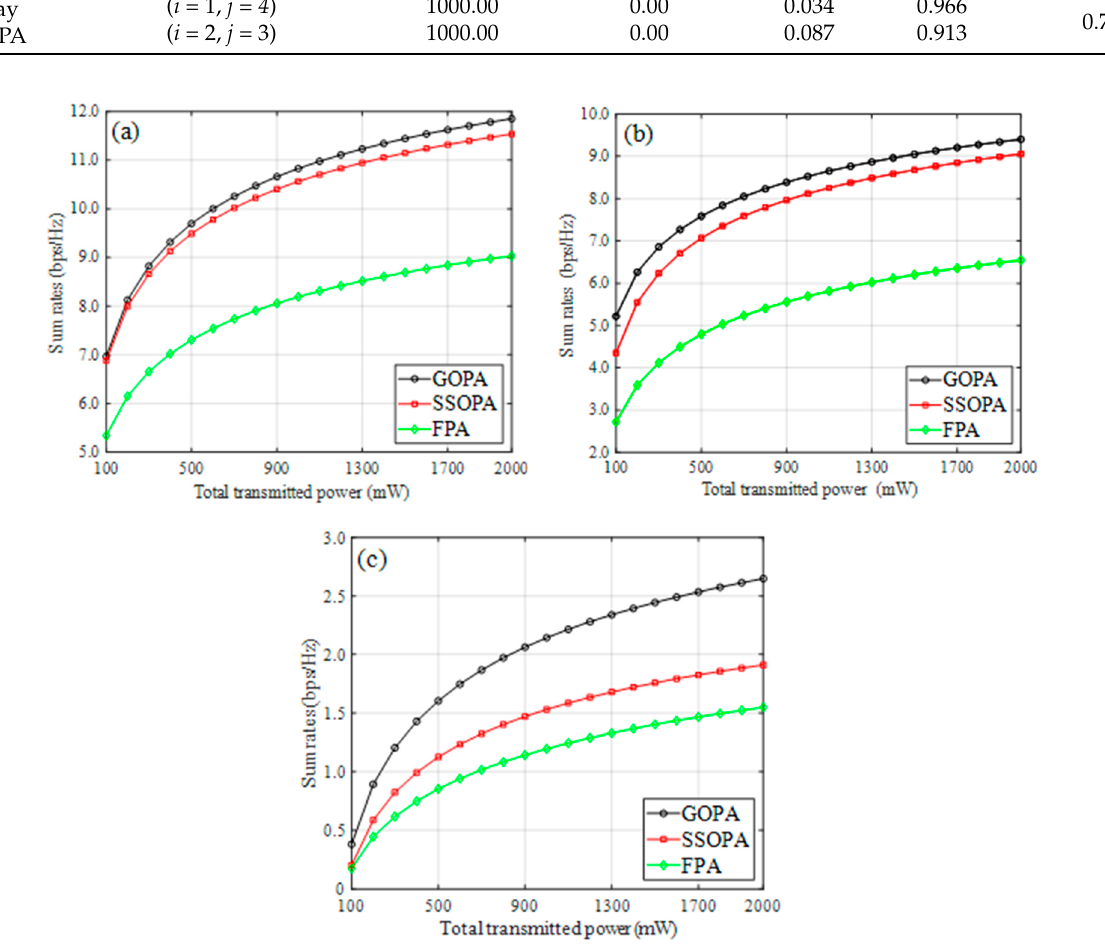
Figure 7. Sum rates versus transmitted power of ICNOMA–UOWC system for ( a ) 𝜎 sci 2 (cid:3404) 0.1 , ( b ) 2 (cid:3404) 0.4 , ( c ) 𝜎 2 (cid:3404) 1.0 . 𝜎 = 0.4, ( c ) σ 2 = ( b ) σ 2 sci sci sci sci